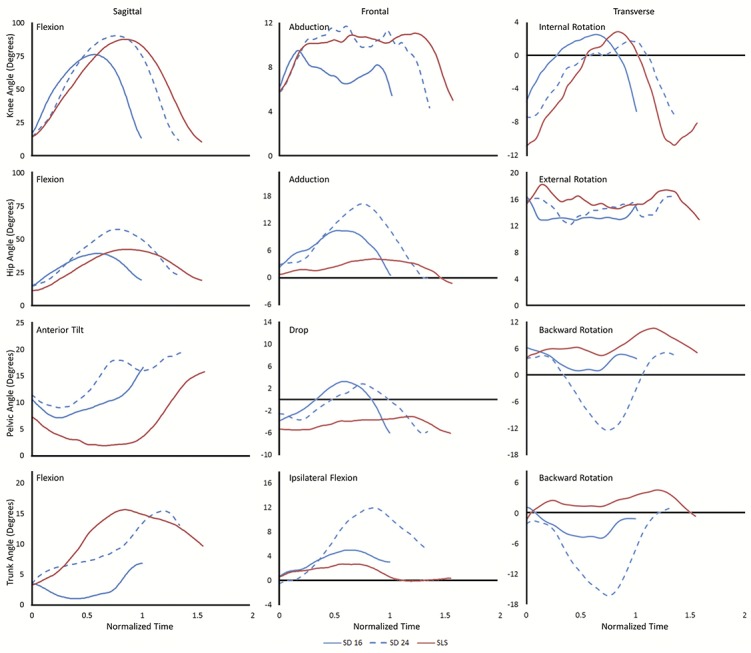
Average knee, hip, pelvis and trunk angles from a representative participant performing each of the three tasks.As the task durations were not equal, data were normalized to maintain the time differences between tasks for presentation purposes only.